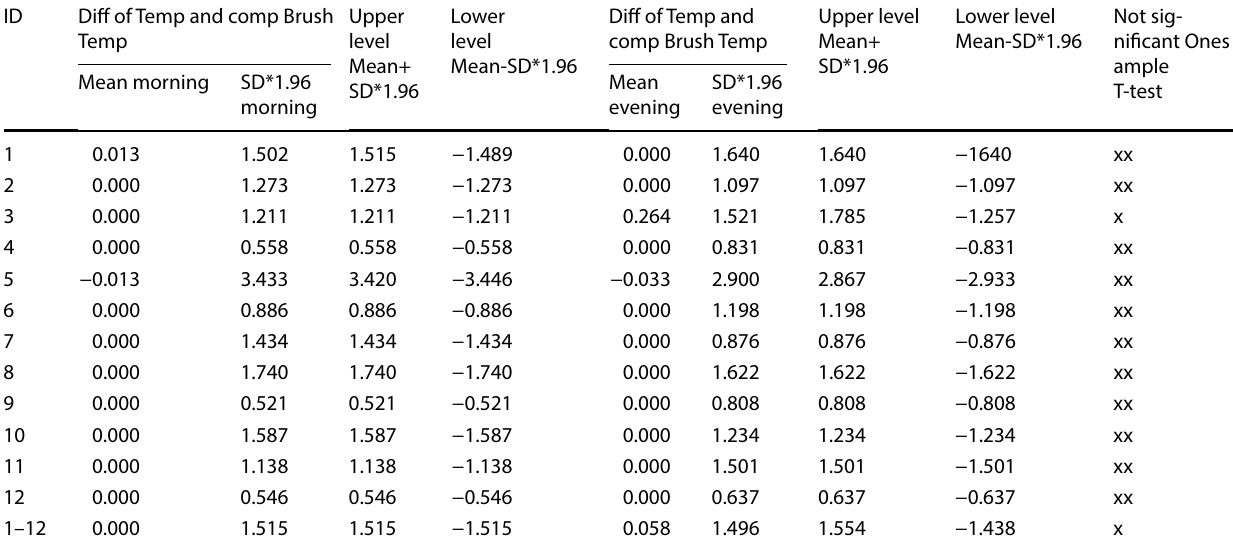
Table 3 Data for Bland-Altman plot, ID